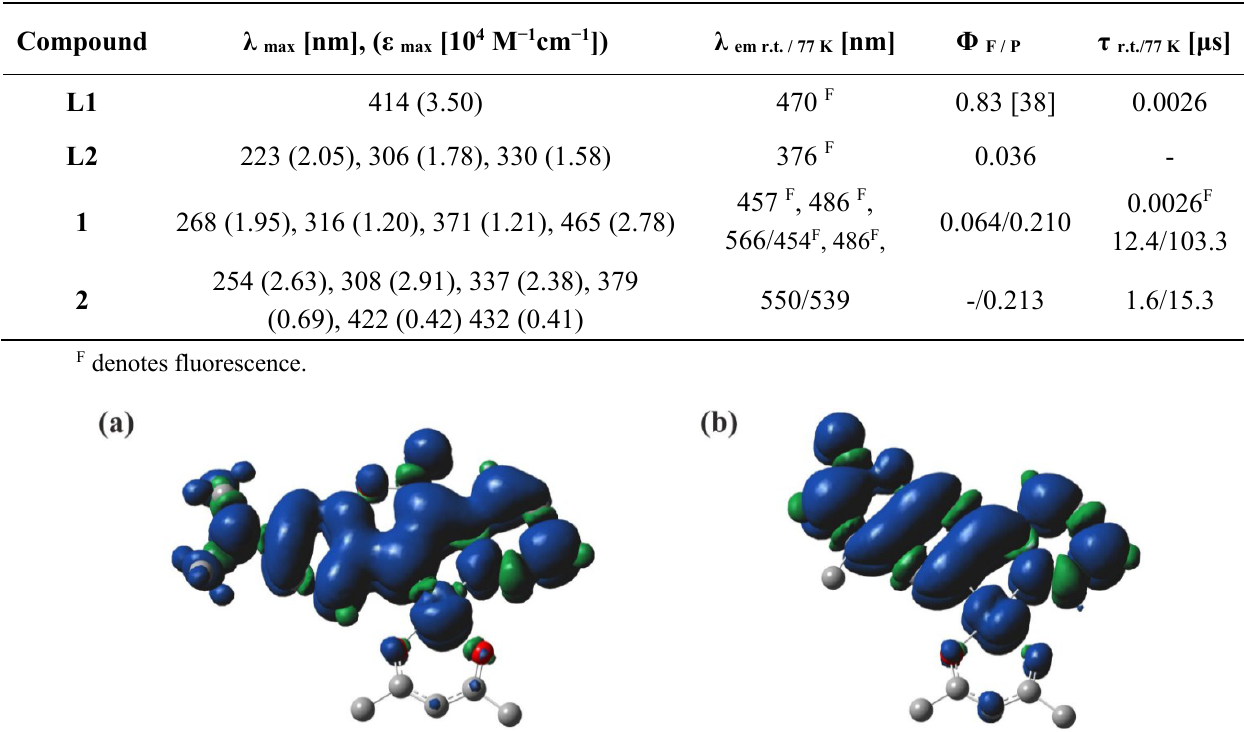
Table 3. Photophysical data for ligands L1 and L2 and complexes 1 and 2 in DCM (r. t.) or 2-MeTHF ( T = 77 K).